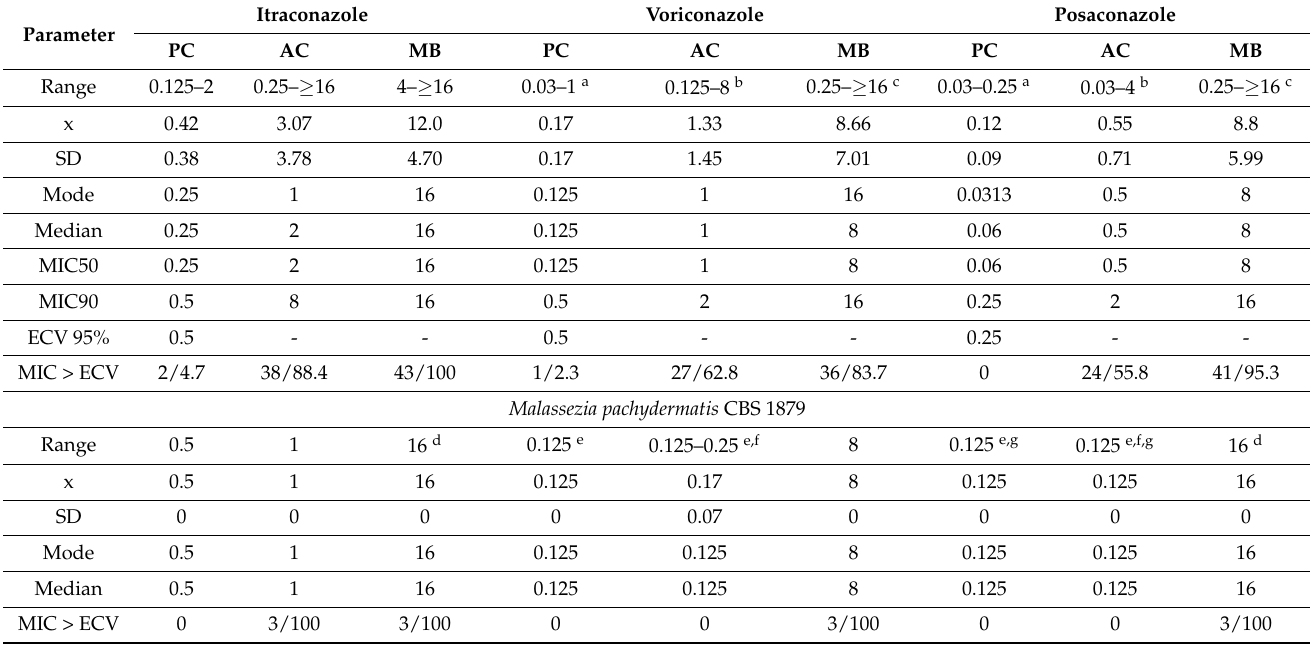
Table 3. Evaluation of MICs ( µ g/mL) in tested